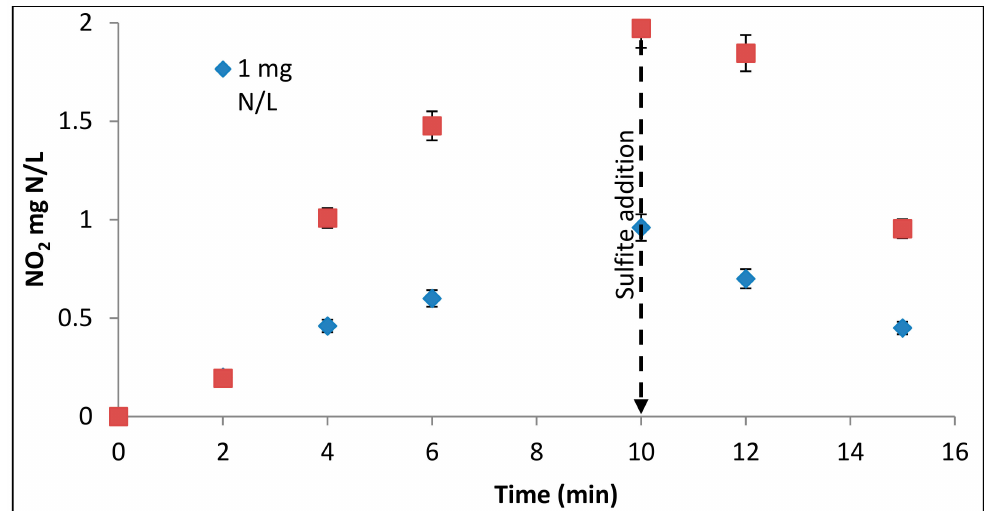
Figure 8. The nitrite concentration during UV/NO 3 (at initial NO 3 − concentrations 1 and 5 mg N/L). Sodium sulfite was added at 10 min, at concentrations 50 and 100 mg/L for the low and high NO 3 − concentrations respectively. The compound 1,4-dioxane was at 10 µ